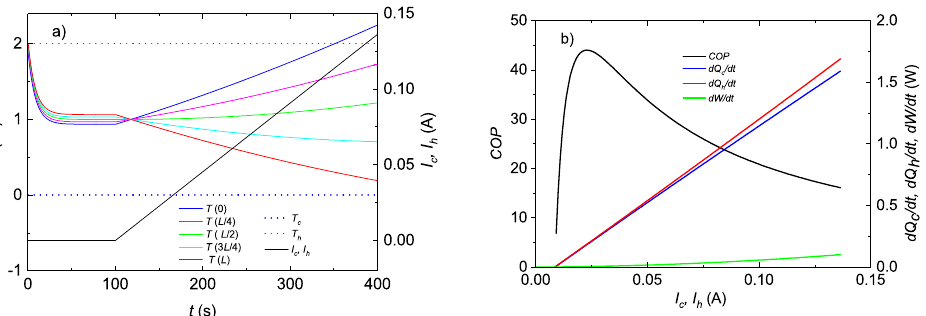
Figure 4. ( a ): Temperature at five different points of the MCM for a constant temperature difference ∆ T = T − T c = 2 K and slowly increasing current at the TE cells, without magnetic field. ( b ): COP , h extracted and released heat powers, ˙ Q c and ˙ Q h , and thermoelectric work power against current at the TE cells.